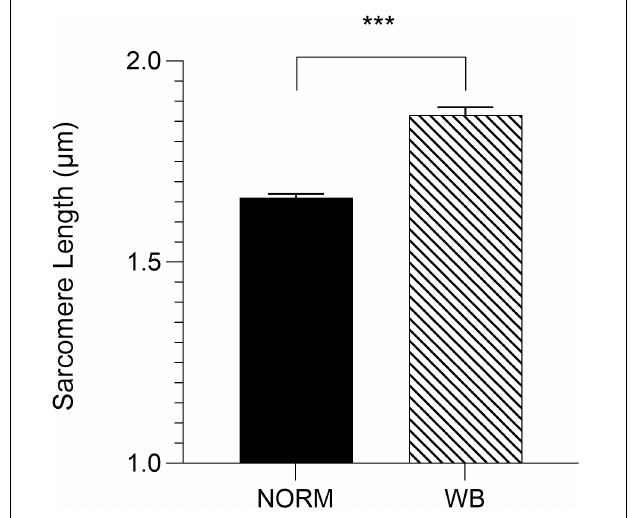
FIGURE 10 | Average sarcomere length ( µ m) assessed in the anteroventral region of unaffected (NORM) and wooden breast (WB)-affected pectoralis major muscles ( n = 6/group). Data represent means ± SEM. *** P < 0.001.